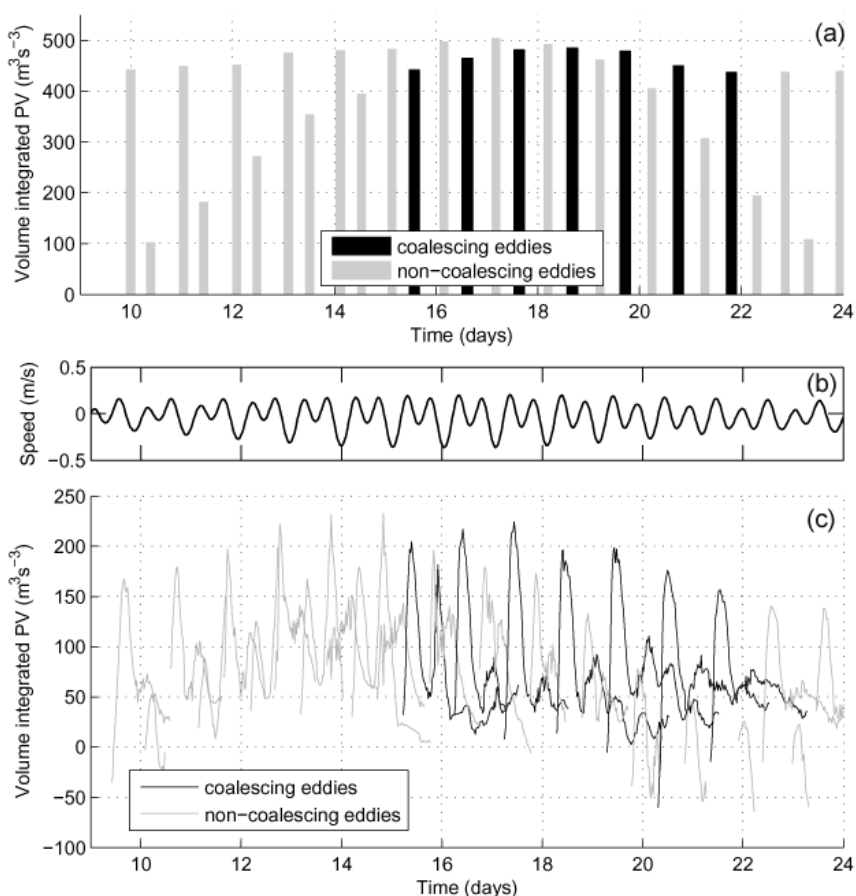
Fig. 12. (a) Positive PV generated by friction on each flood tide between the first and second neap tides in the generational region shown in Fig. 11. Bars shown in black indicate eddies which coalesce. (b) Tidal speed near the cape. (c) Volume-integrated potential vorticity contained in each positive-PV eddy generated between the first and second neap tides. Each eddy was tracked until it became obvious which direction it was heading, so some eddies are tracked longer than others. The eddies which eventually coalesce to form the feature of interest are shown in black, all other eddies are shown in grey. The cross-shelf tidal velocity is shown in the upper panel; we can see here that the eddies which coalesce are generated on a strong flood tide which is followed by a weak